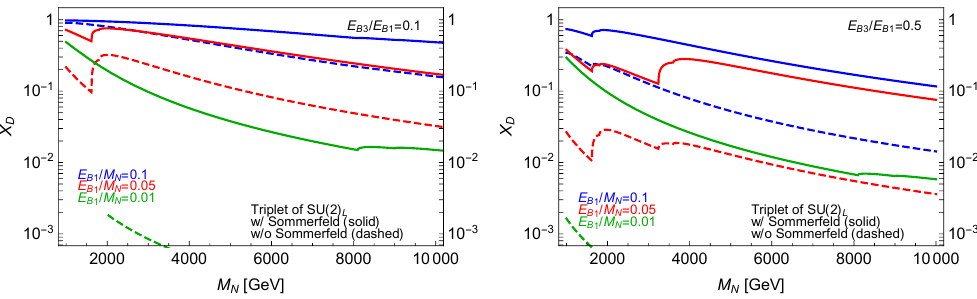
Figure 2 . Dark deuterium mass fraction X D as a function of the nucleon mass M N for several choices of the binding energies (with and without the Sommerfeld